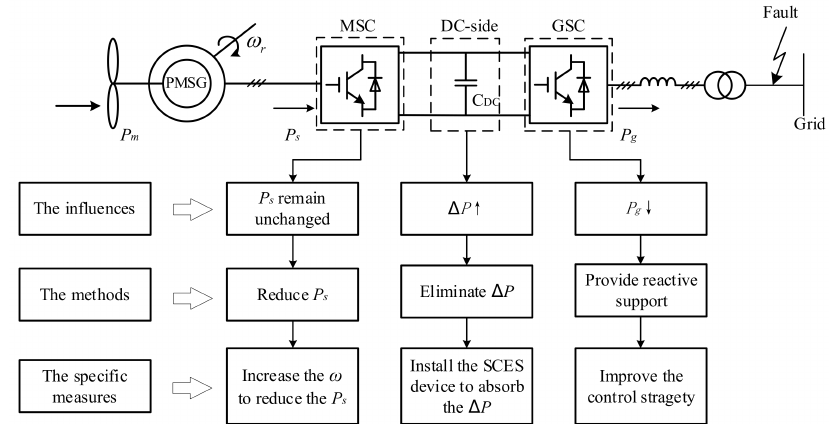
Figure 2. The technical principle of low voltage ride through